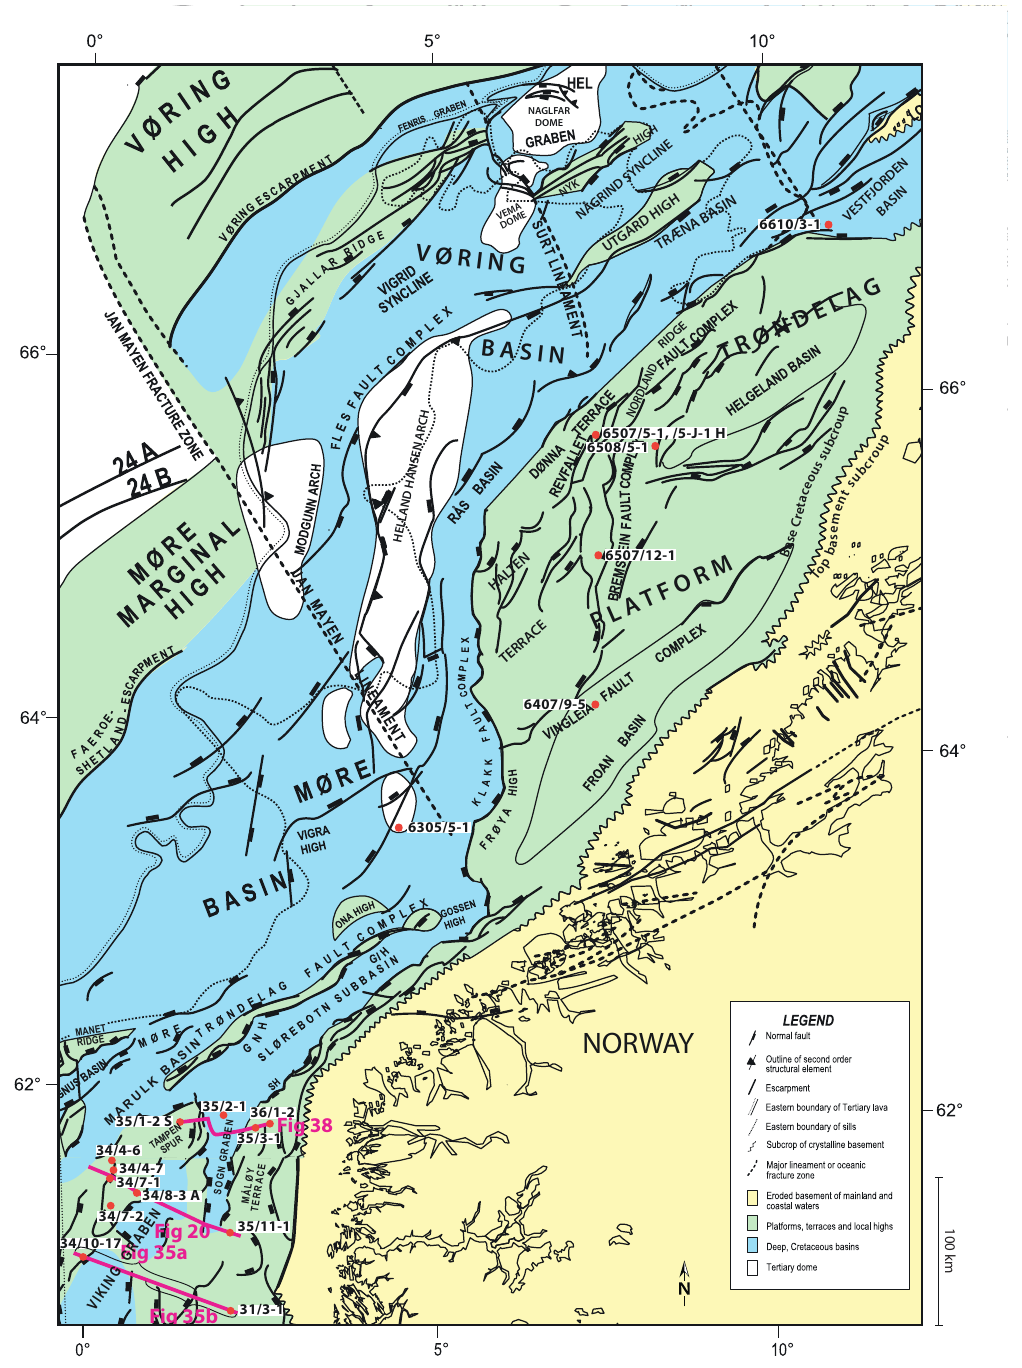
Figure 6. Map showing structural elements and seismic lines in the Norwegian Sea, on the Norwegian Sea continental shelf and in the northernmost part of the North Sea. Red dots are investigated wells and boreholes (modified after Brekke, 2000; Eidvin et al., 2013d,